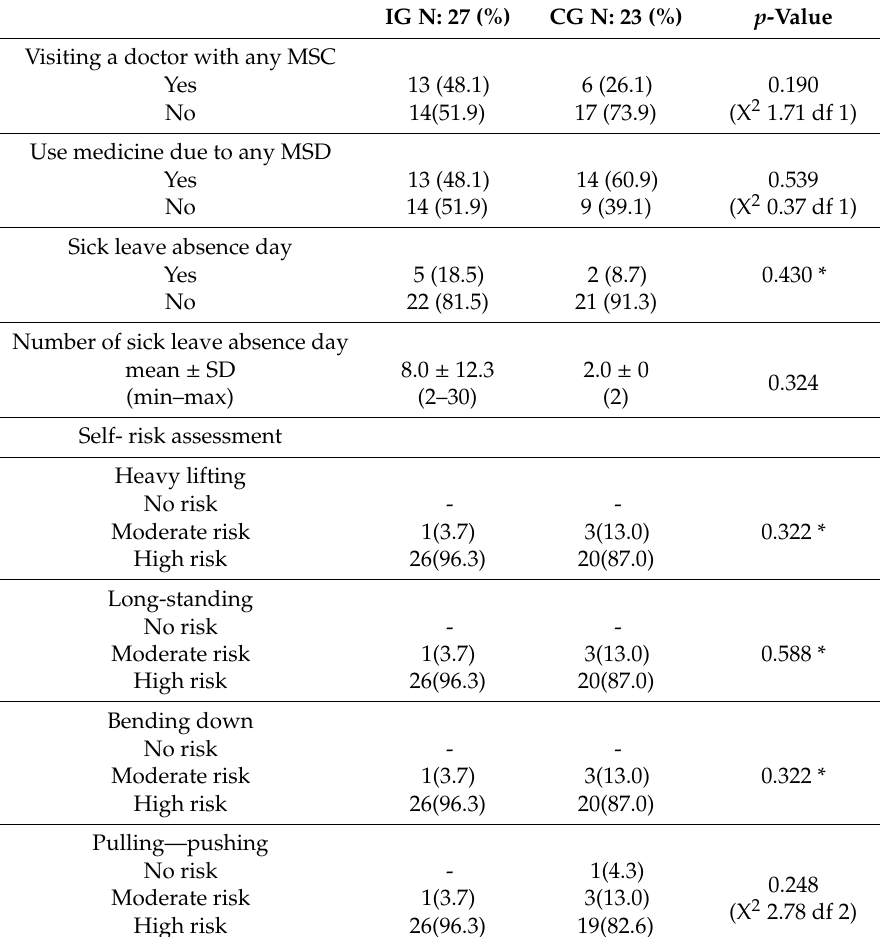
Table 5. Between-group analysis in the 18th month (IG vs.